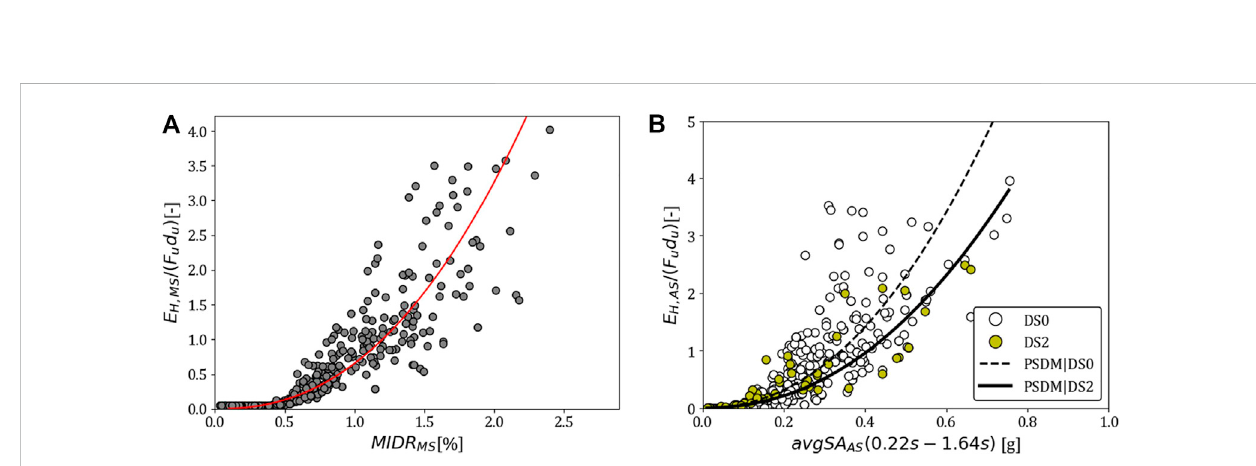
FIGURE 12 (A) E H vs. MIDR relationship for undamaged con fi guration and MS only; (B) E H vs. IM AS relationship for undamaged con fi guration and initial DS2 con fi